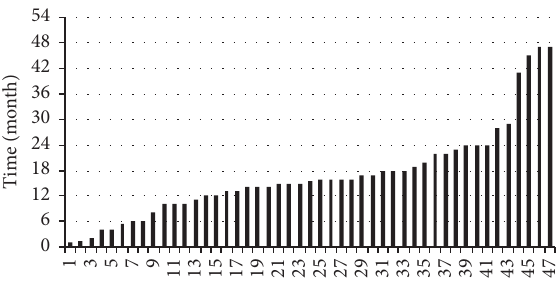
Figure 1: Observation time. Table 1: Coexisting preoperative ocular pathologies.